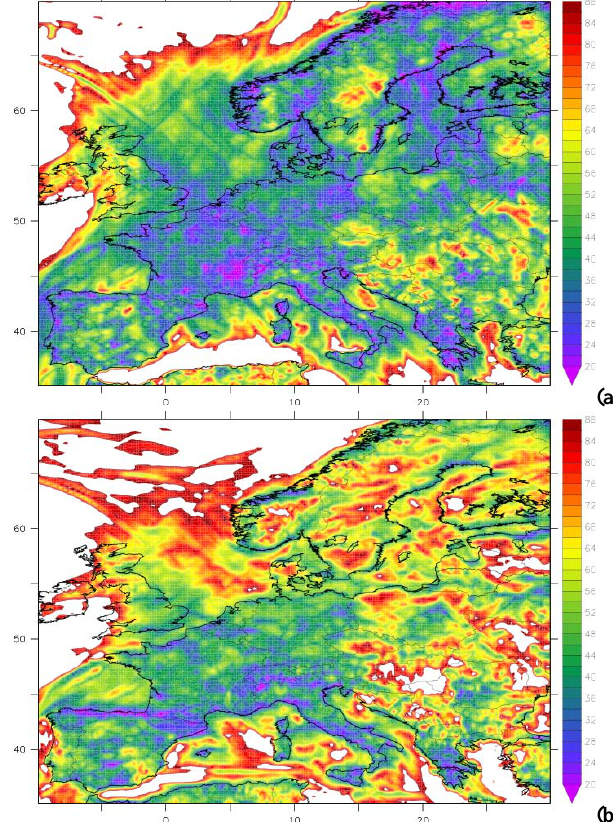
Fig. 2. Diagnosed standard deviation from a posteriori diagnostics (ppb), averaged in the period between 1 and 10 July 2010 (a) and the period between the 1 and 10 December 2010 (b) .